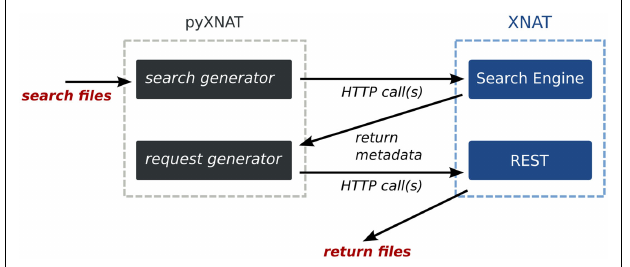
FIGURE 6 | PyXNAT integration of the search engine and the files